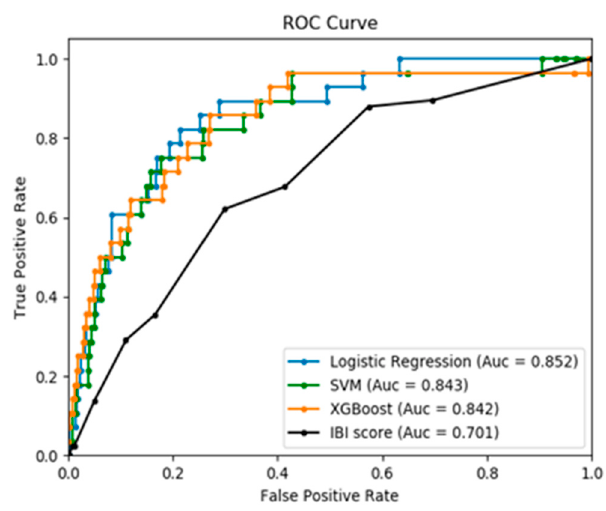
Figure 1. Receiver-operating characteristic (ROC) curves of the IBI score and the developed ma- chine learning models on the validation set; SVM = Support vector machine; XGBoost = Extreme gradient boosting.